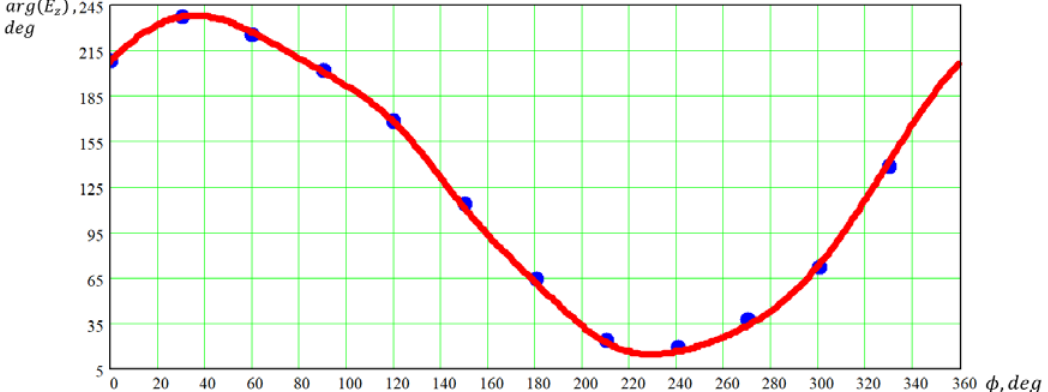
Figure 4. Phase distributions of E z -field on a circle with radius r = 1 m (antenna array radius R = 0.5 m) Figure 4. Phase distributions of 𝐸 (cid:3053) ‐ field on a circle with radius 𝑟 (cid:3404) 1 m (antenna array radius 𝑅 (cid:3404) obtained by numerical simulation (circles) and approximation (solid lines) at frequency f = 90 0.5 m) obtained by numerical simulation (circles) and approximation (solid lines) at frequency 𝑓 (cid:3404) Figure 4. Phase distributions of 𝐸 (cid:3053) ‐ field on a circle with radius 𝑟 (cid:3404) 1 m (antenna array radius 𝑅 (cid:3404) 90 MHz. 0.5 m) obtained by numerical simulation (circles) and approximation (solid lines) at frequency 𝑓 (cid:3404) 90 MHz.